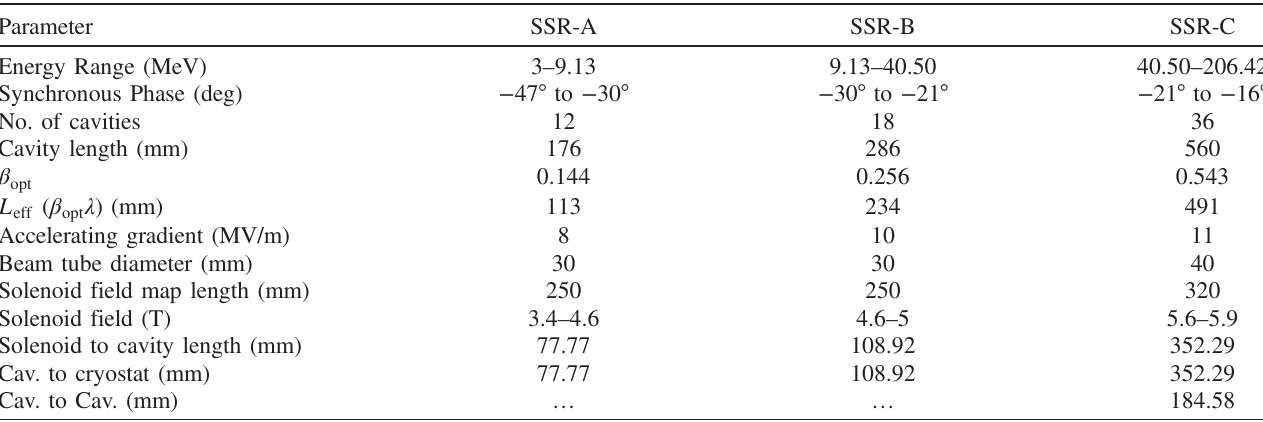
TABLE VII. Parameters for the superconducting section of